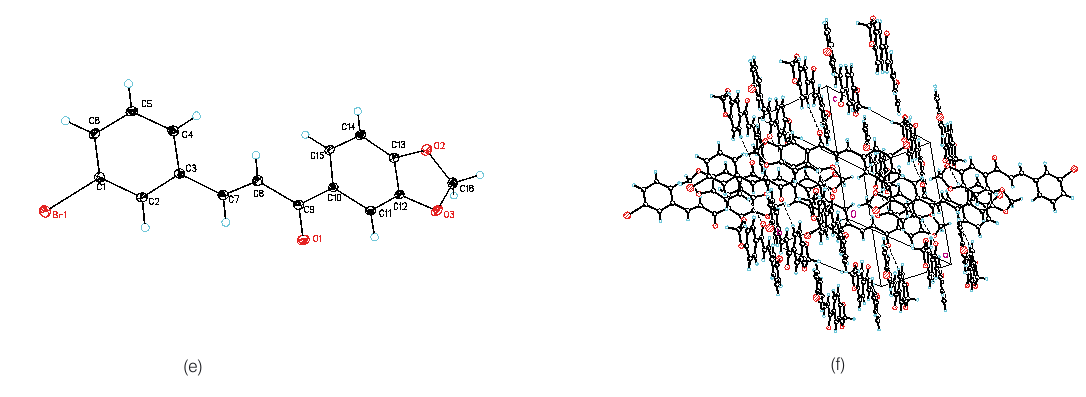
Figure 3. Ortep drawings (e) and molecular packing (f) for